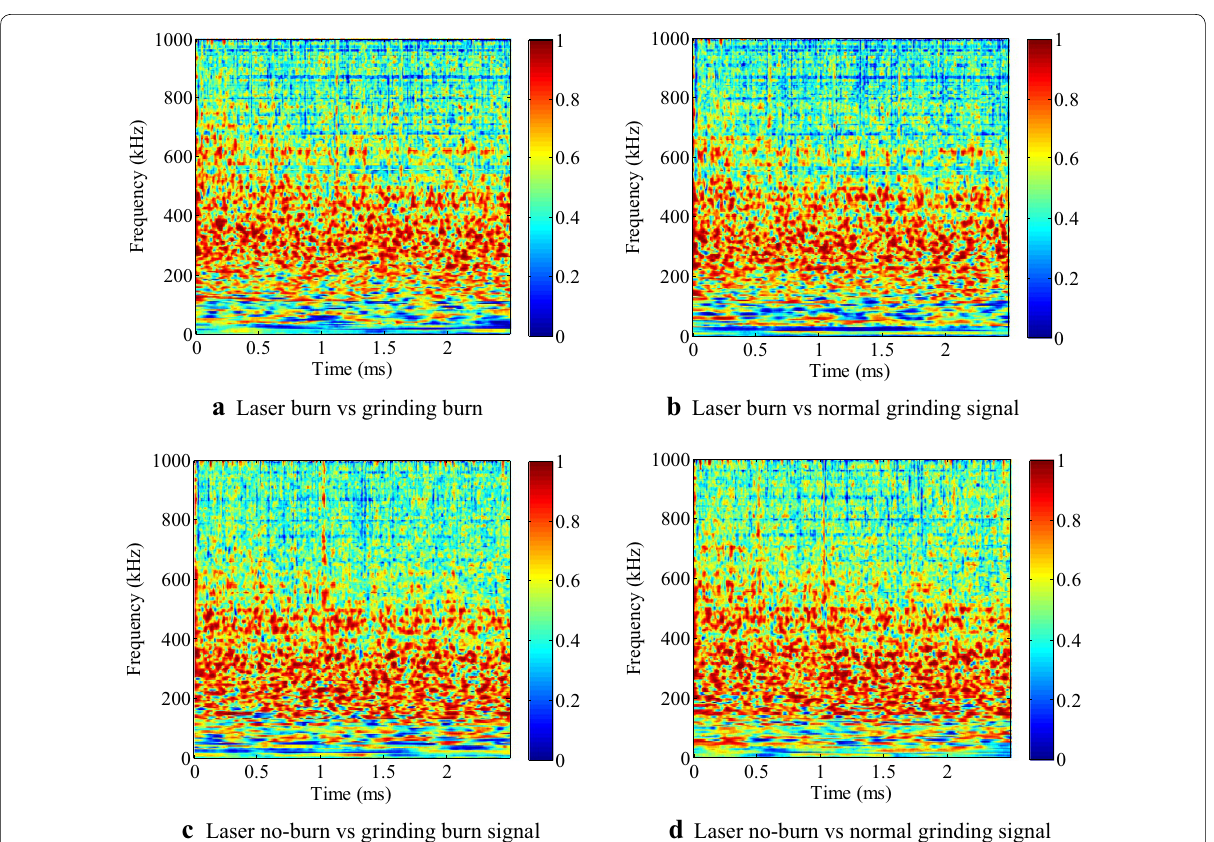
Figure 9 WTC result of the laser signal and grinding signal